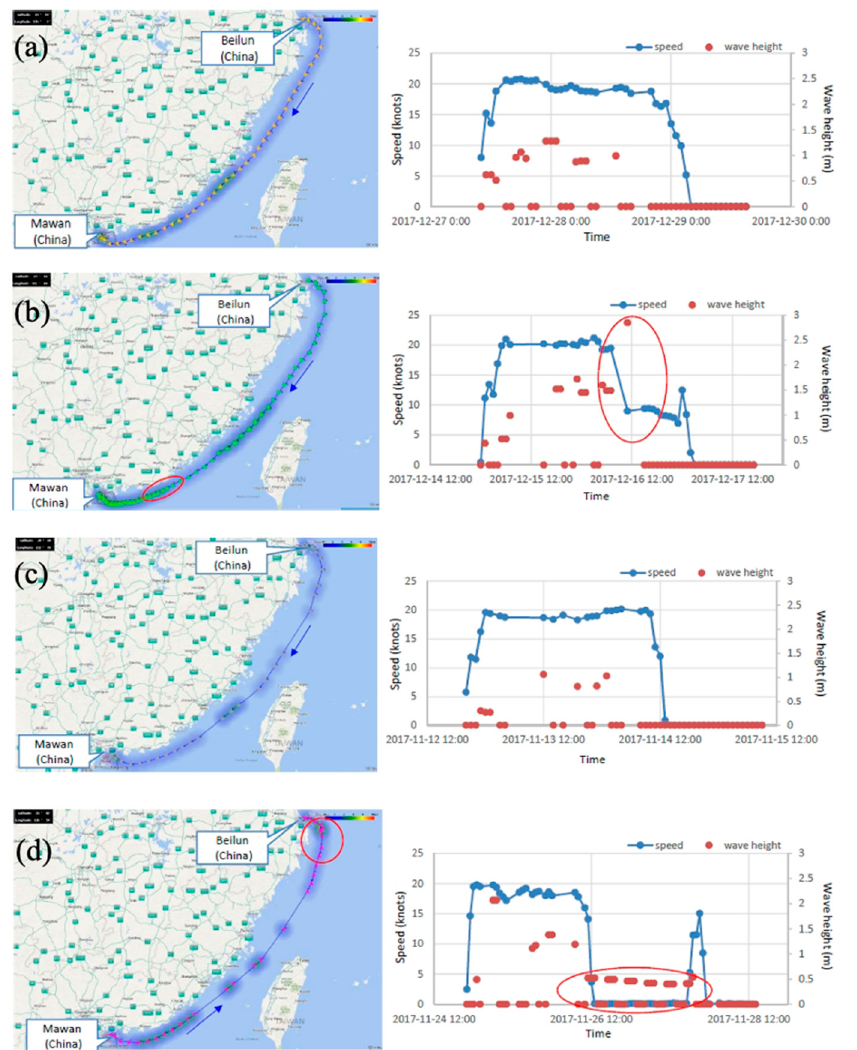
Figure 8. Past operation comparison for the series container ships. ( a ) Voyage of the ship 1, 27~29 December, 2017 (2 days), average speed 17.49 knots, ( b ) Voyage of the ship 2, 15~17 December, 2017 (2 days), average speed 18.25 knots, ( c ) Voyage of the ship 3, 12~15 November, 2017 (3 days), 18.77 knots, ( d ) Voyage of the ship 4, 24~28 November, 2017 (4 days), average speed 16.54 knots.